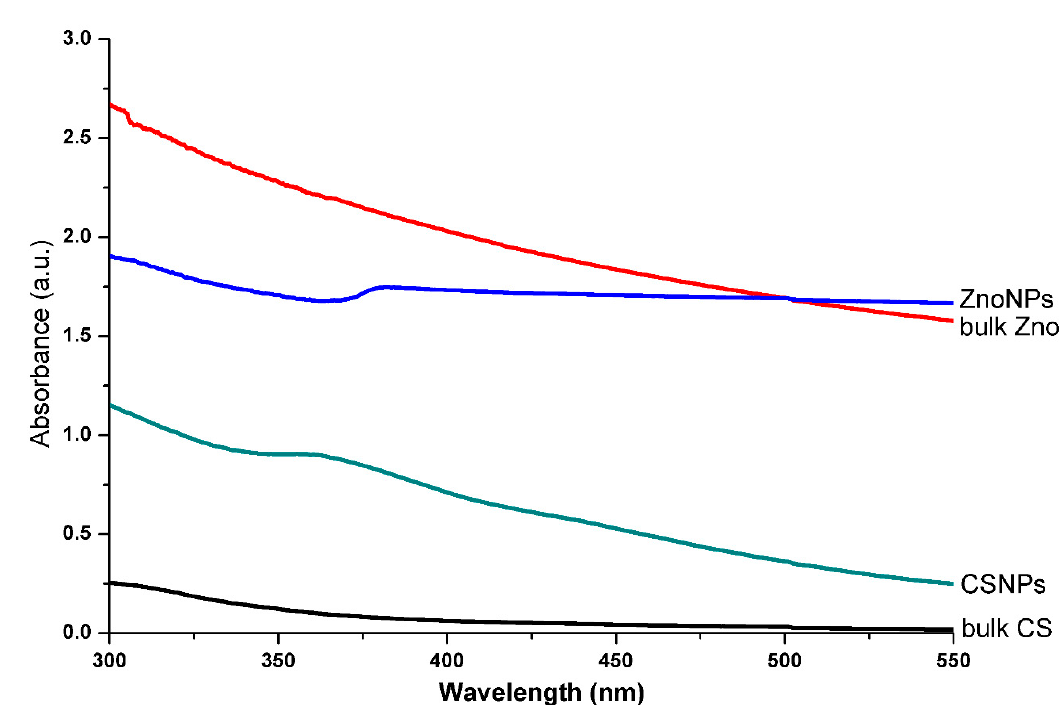
Figure 2. The UV-visible spectrum of bulk chitosan (CS), CSNPs, bulk ZnO, and ZnONPs solutions.